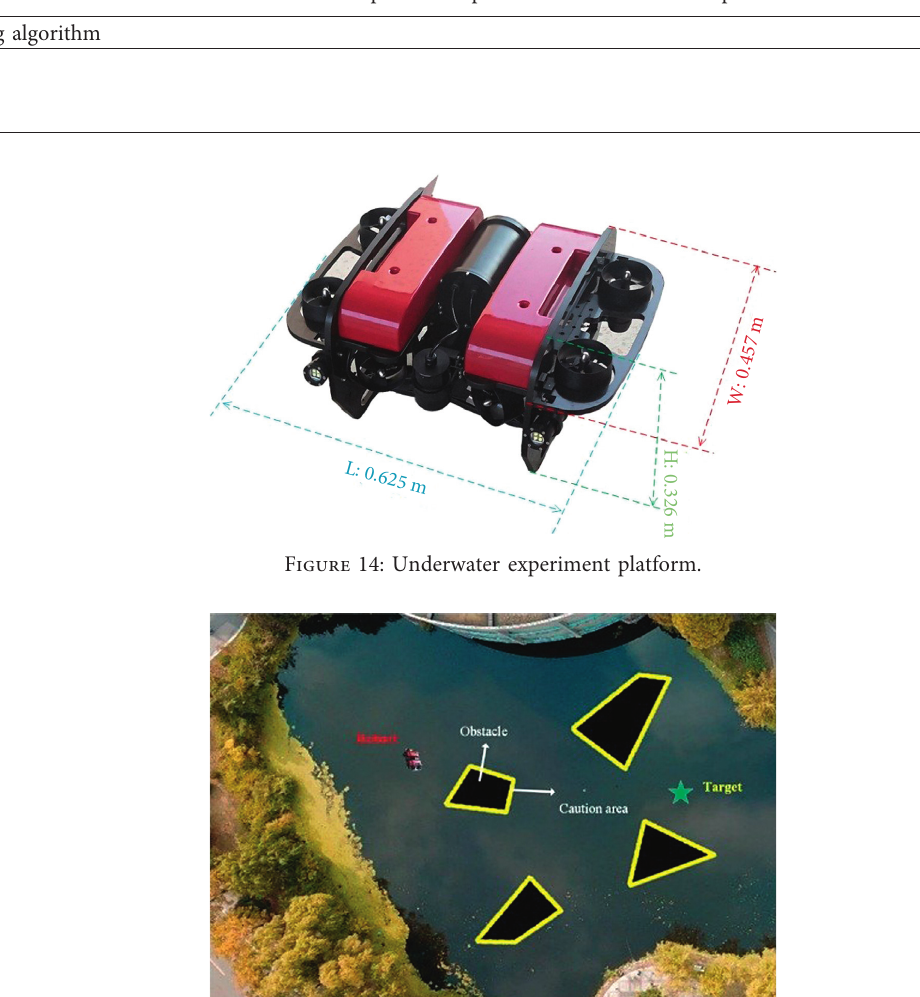
Figure 13: Trajectory comparisons for different algorithms based on raster maps. Table 3: Comparison of path distances in raster maps.